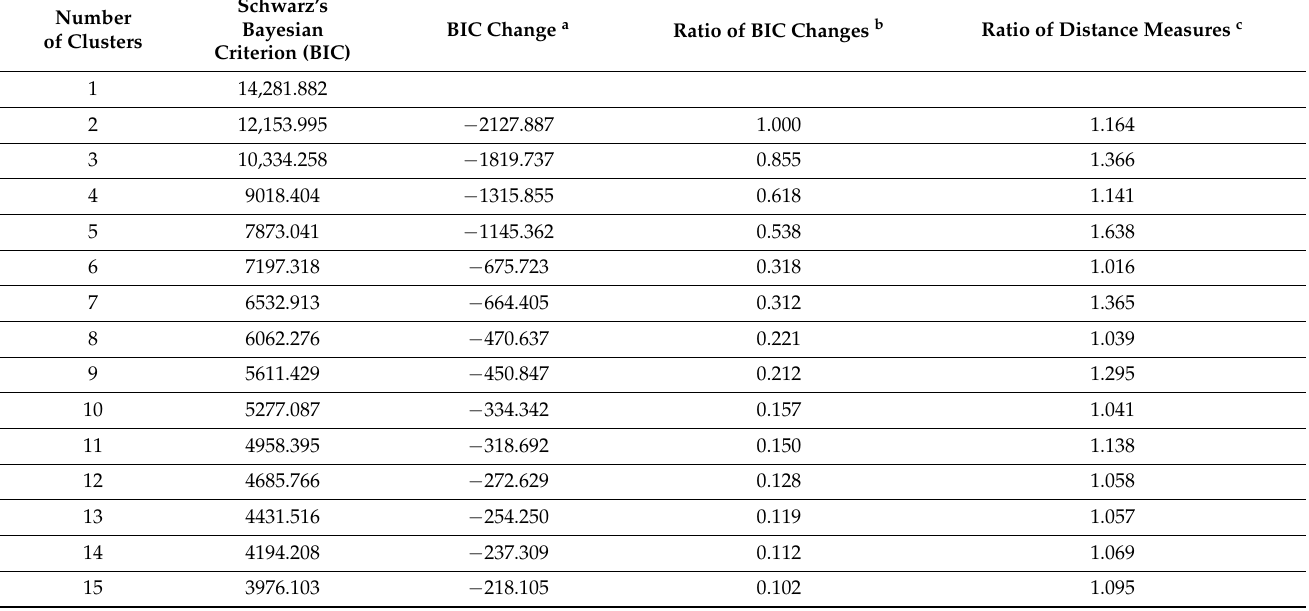
Table 3. Auto-Clustering.